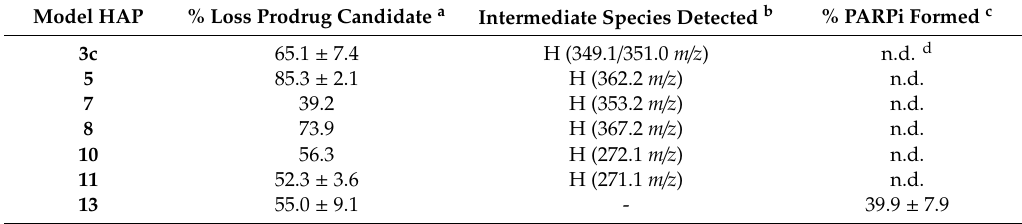
Table 2. Summary of radiolytic reduction results for immediate analysis following 40 Gy irradiation in anoxic formate bu ff er.